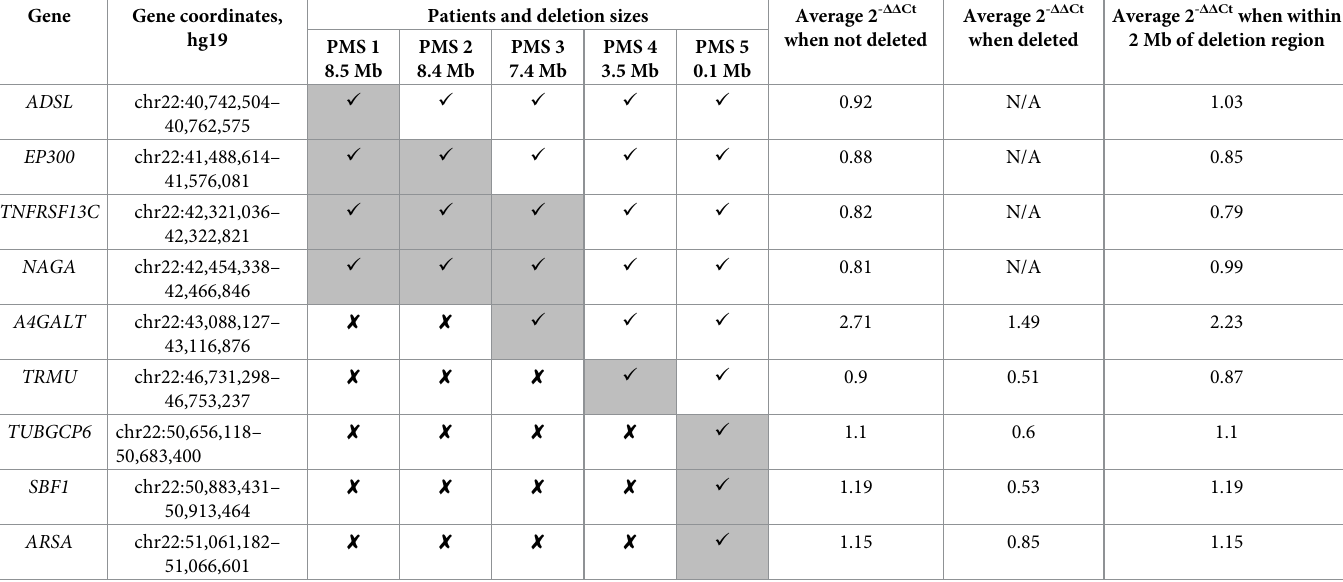
Table 2. Expression levels of 9 genes on 22q13 investigated as candidates for transcriptional misregulation. Gene Gene coordinates, hg19